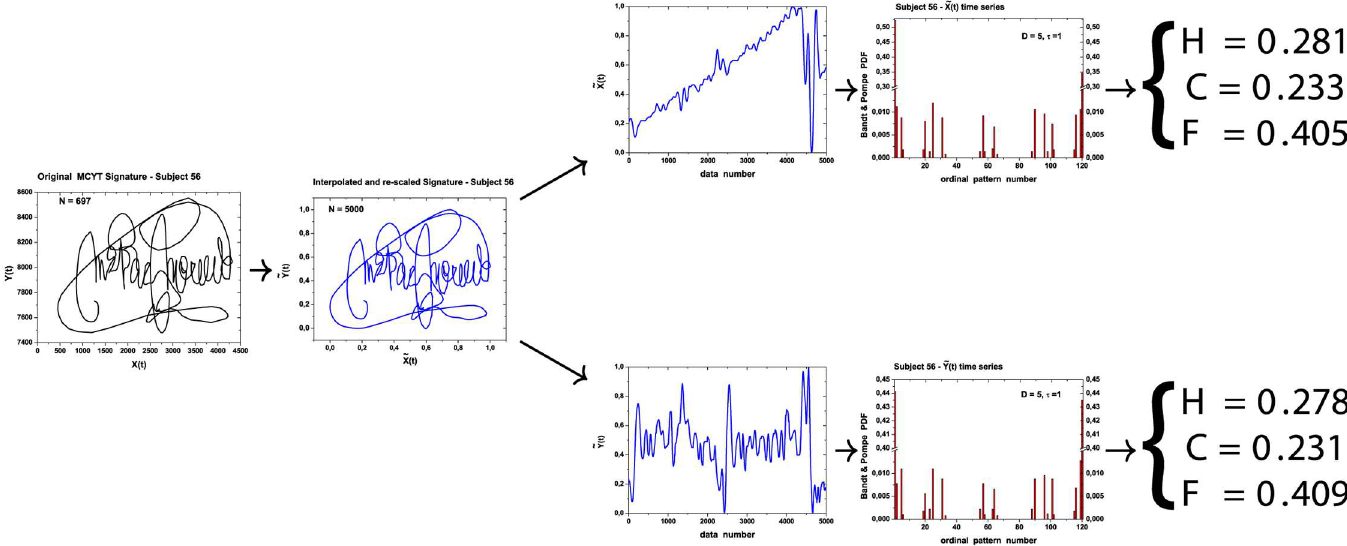
Fig 1. Diagram of the proposed procedure: original signature, interpolation, X and Y coordinates as time series, Band & Pompe histograms, entropy, statistical complexity and Fisher